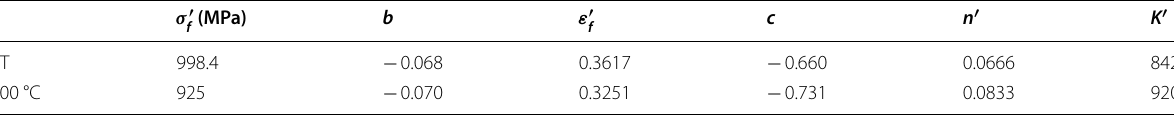
Table 2 Low cycle fatigue parameters at two different temperatures